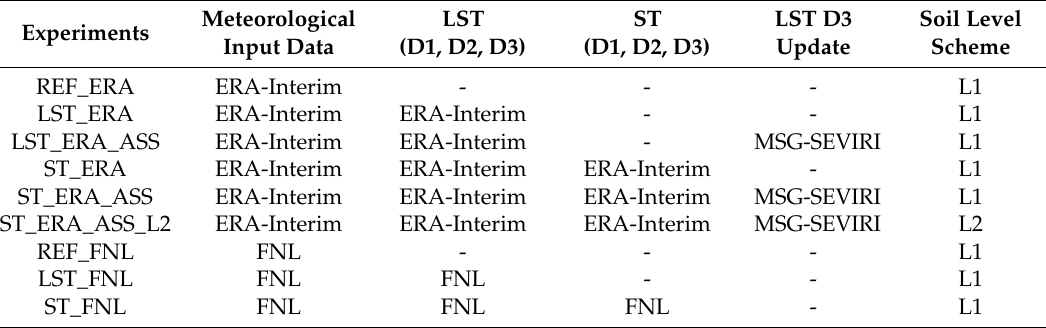
Table 1. Sensitivity experiments performed using the RAMS model and the corresponding settings in terms of initialization data. L1 is the soil level scheme corresponding to 11 soil levels for the soil model with higher resolution on the uppermost layers down to a depth 50 cm below the surface, while L2 includes 13 soil levels with higher resolution on the uppermost layers down to a depth 150 cm below the surface (two extra soil levels at ´ 1.00 and ´ 1.50 m below the